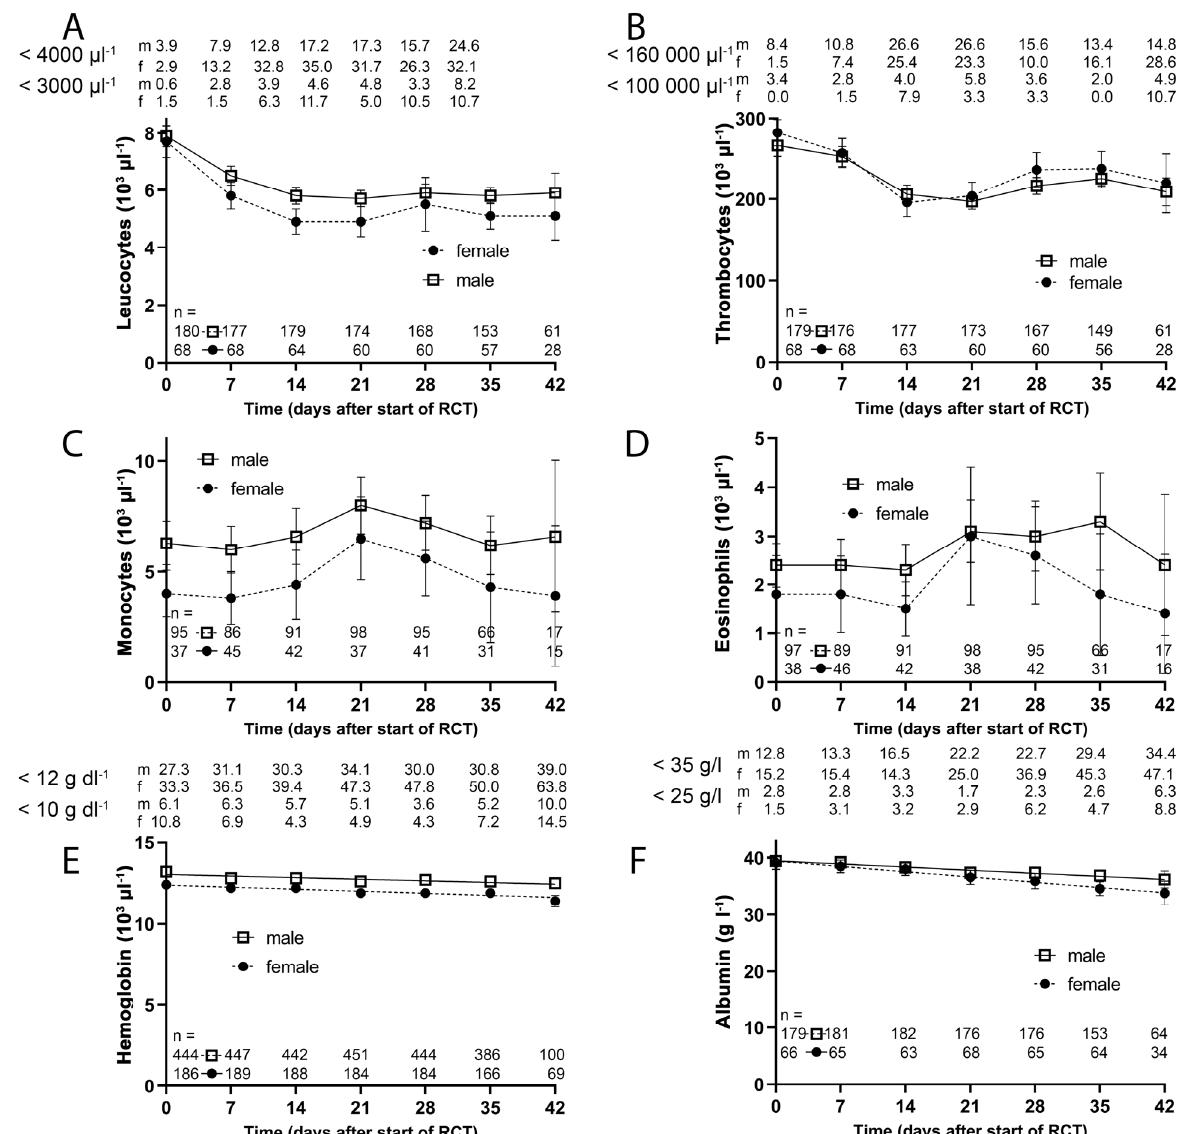
Figure 7. Blood values prior to and during the RCT of the lab data cohort. The filled dots represent women and the open rectangles represent men. The number of people with blood samples is indicated. The number of ( A ) Leukocytes; ( B ) Platelets; ( C ) Monocytes; ( D ) Eosinophils and the amount of ( E ) hemoglobin and ( F ) Albumin were given. Length of the error bars is the 95% confidence interval for the mean. m = male, f = female .